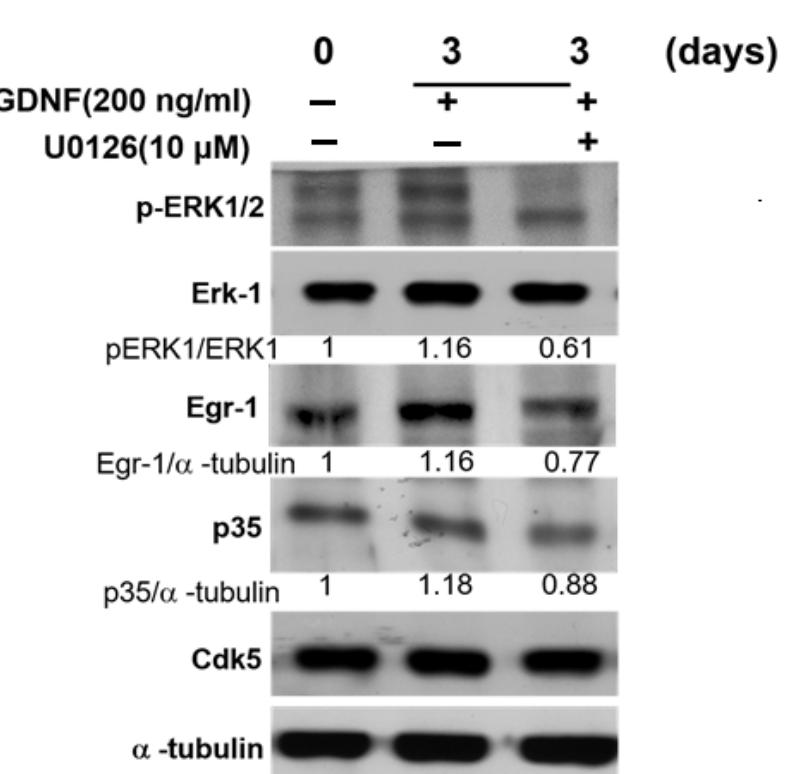
Figure 4. GDNF-induced p35/CDK5 activity is ERK-EGR1 signaling-dependent. The protein expres- sion level of pERK1/2, ERK1, EGR1, p35 and CDK5 under GDNF and ERK inhibitor (U0126) for 3 days.